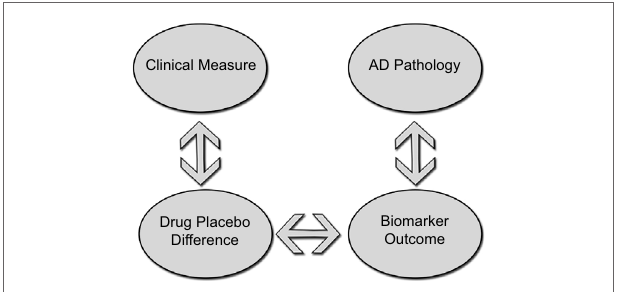
FiGURe 2 | Standard parallel group design to demonstrate disease modification groups receiving active treatment and placebo would be compared on clinical measures while an effect on disease pathology would be demonstrated by showing differences on a biomarker measure of disease progression . A correlation between drug–placebo difference and a biomarker outcome could potentially support a claim of disease